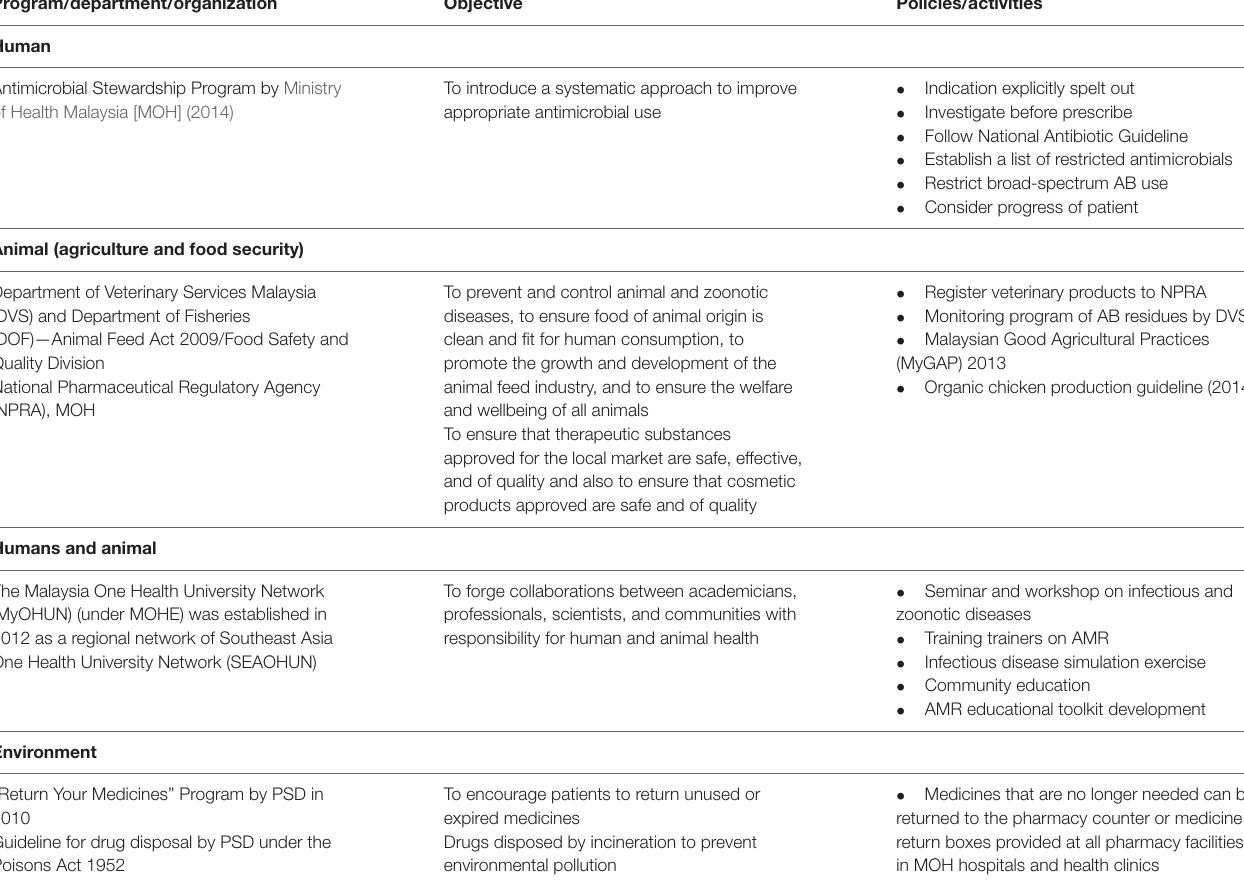
TABLE 4 | Malaysian One Health implementation